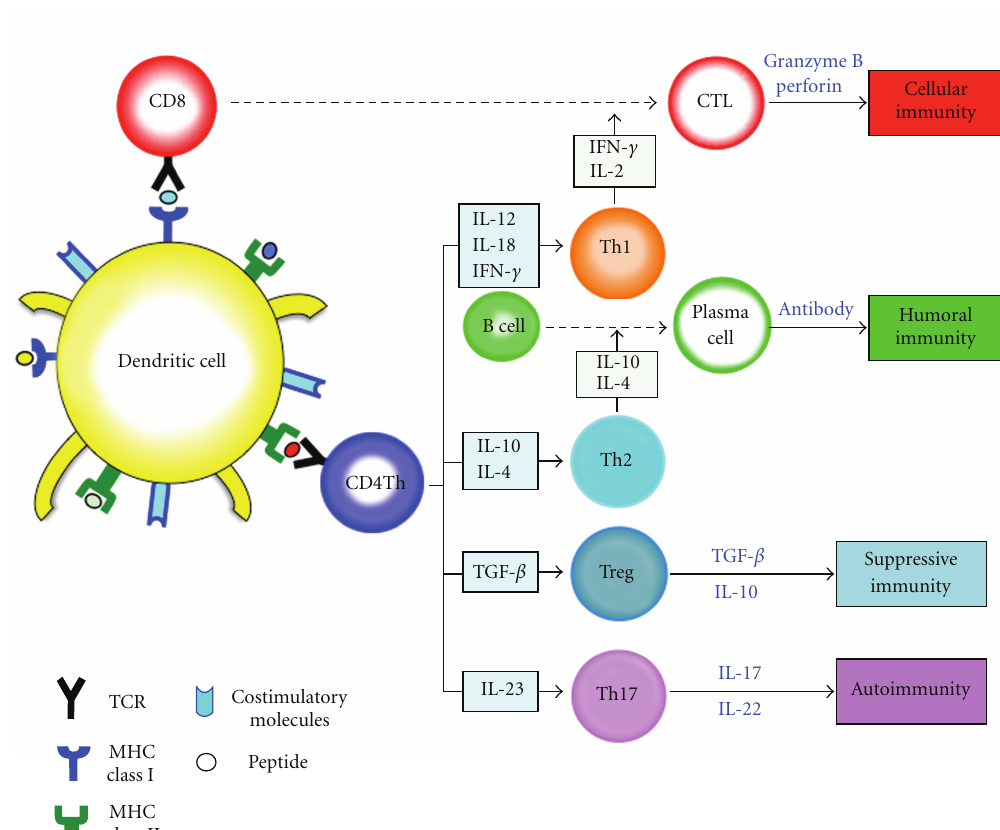
Figure 2: Immune homeostasis. Upon TCR-mediated cell activation, naive CD4 T cells can di ff erentiate into four major lineages, Th1, Th2, Th17, and Treg cells that participate in di ff erent types of immune responses. The Th1 cells produce IFN- γ and IL-2, resulting in induction of CD8+ CTLs. Th2 cells secrete IL-4 and IL-10. The Th2 response is associated with the humoral, antibody-based antitumor response. Th17 cells secrete IL-17 and IL-22, eliciting tissue inflammation implicated in autoimmunity. Treg cells that secrete TGF- β and IL-10 suppress e ff ector Th1 or Th2